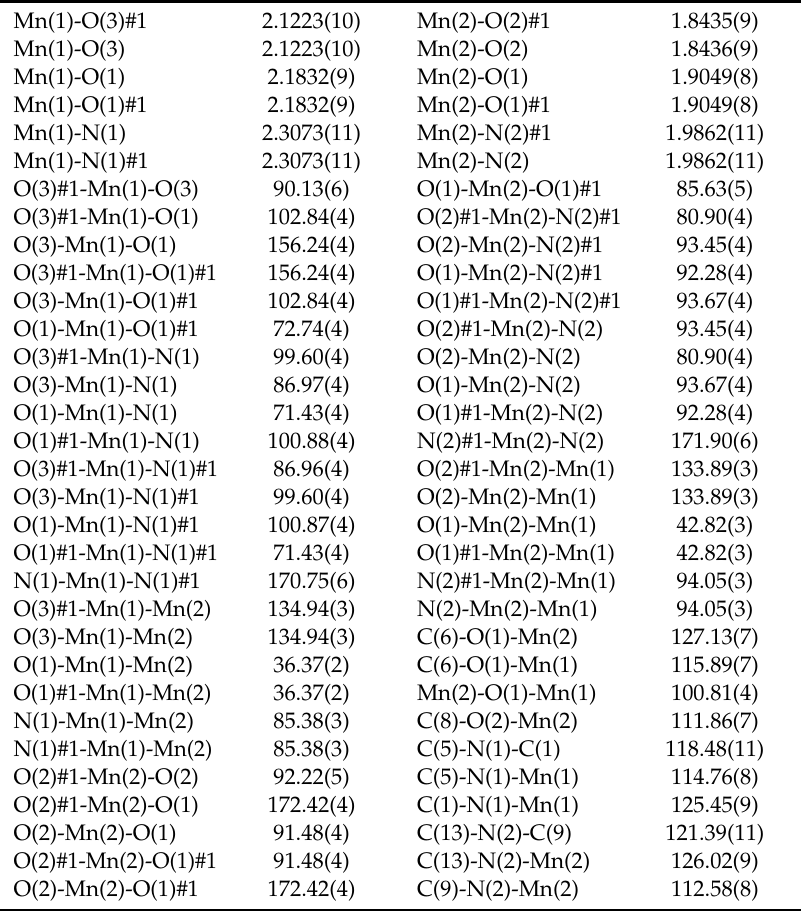
Table 3. Selected bond distances (Å) and angles (deg) of compound 2 .